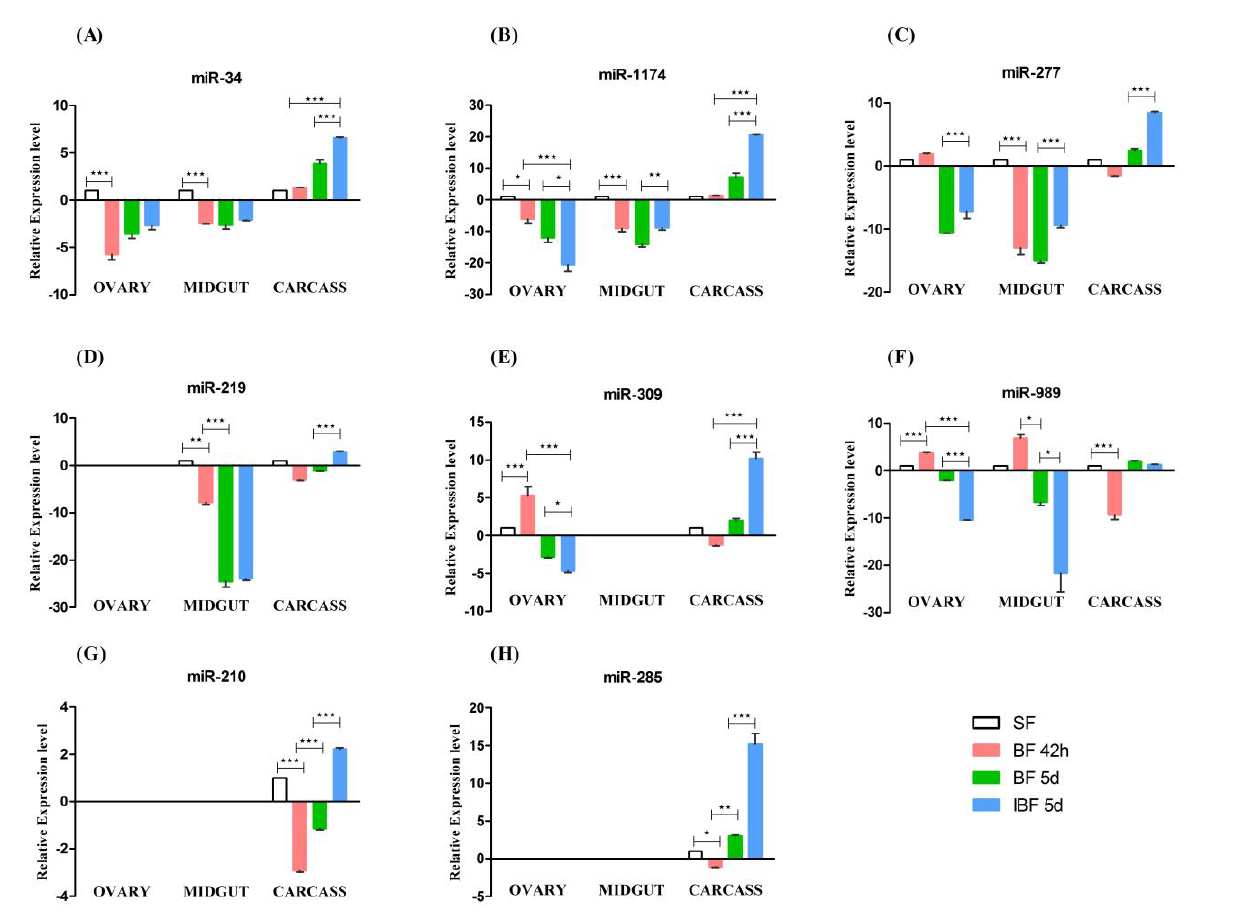
Figure 2. Tissue specific profiling of miRNAs by RT-PCR. Expression profiling of eight miRNAs, ( A ) miR-34; ( B ) miR -1174; ( C ) miR-277; ( D ) miR-219; ( E ) miR-309, ( F ) miR-989; ( G ) miR-210 and ( H ) miR-285 in ovary, midgut and carcass tissue of sugar fed (SF), female mosquito at 42 h (BF 42 h) and 5 days (BF 5d) post blood-feeding and mosquitoes at 5 days post Plasmodium infection (iBF 5d). Fold change was calculated using 2 −ΔΔC method. SF was used as a calibrator, with its fold change taken as 1. Values are mean T ± s.e.m of three biological replicates profiled in triplicate reactions. Data was statistically analyzed by one-way ANOVA followed by Tukey’s multiple comparisons test. * p < 0.05 was considered significant ( ** p < 0.01, *** p <